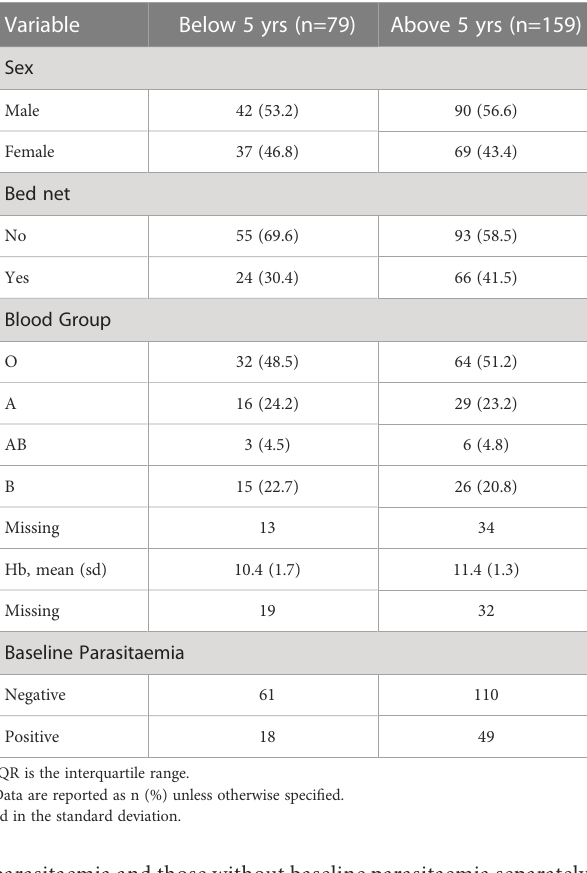
TABLE 1 Baseline characteristics